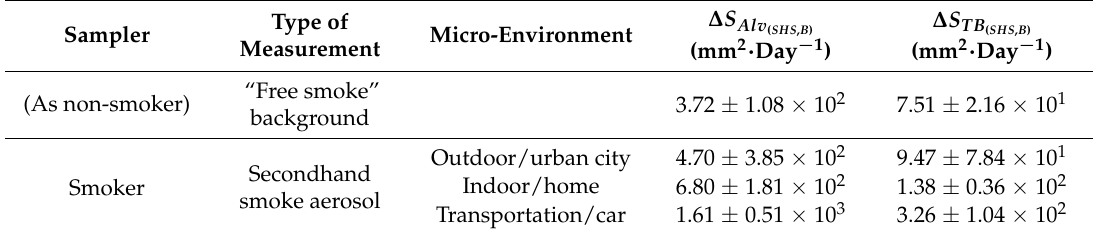
Table 4. Particle surface area doses per day received related to the extra dose due to secondhand smoke aerosol (SHS) and the level of “free smoke” particle background